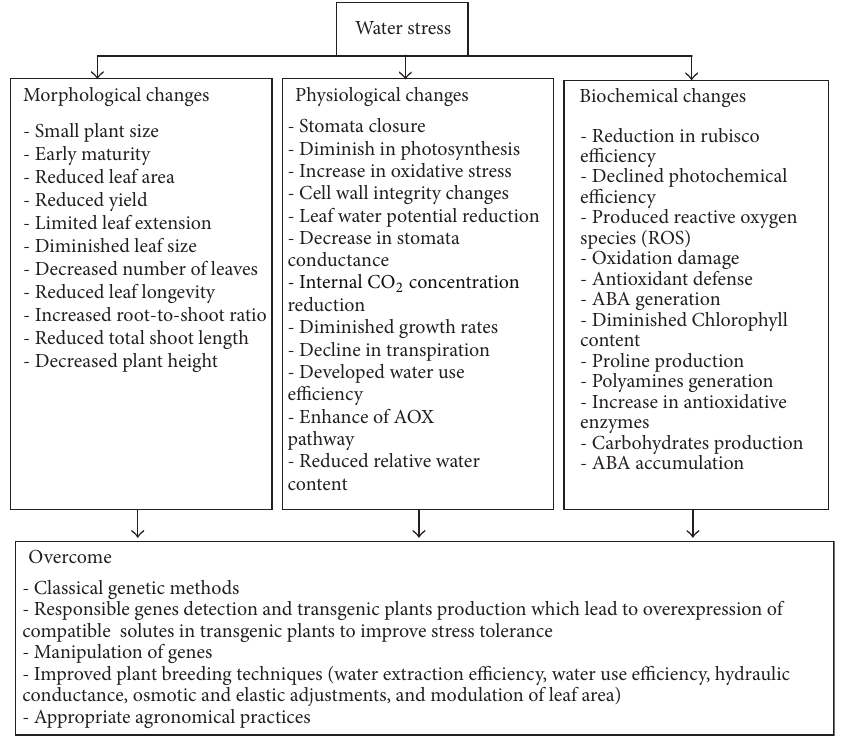
Figure 1: The effect of drought stress on wheat. The information are provided from the observations of Powel et al. [128], Lawlor and Cornic [13], Shiran and Wan [15], Karthikeyan et al. [41], and Russell et al.